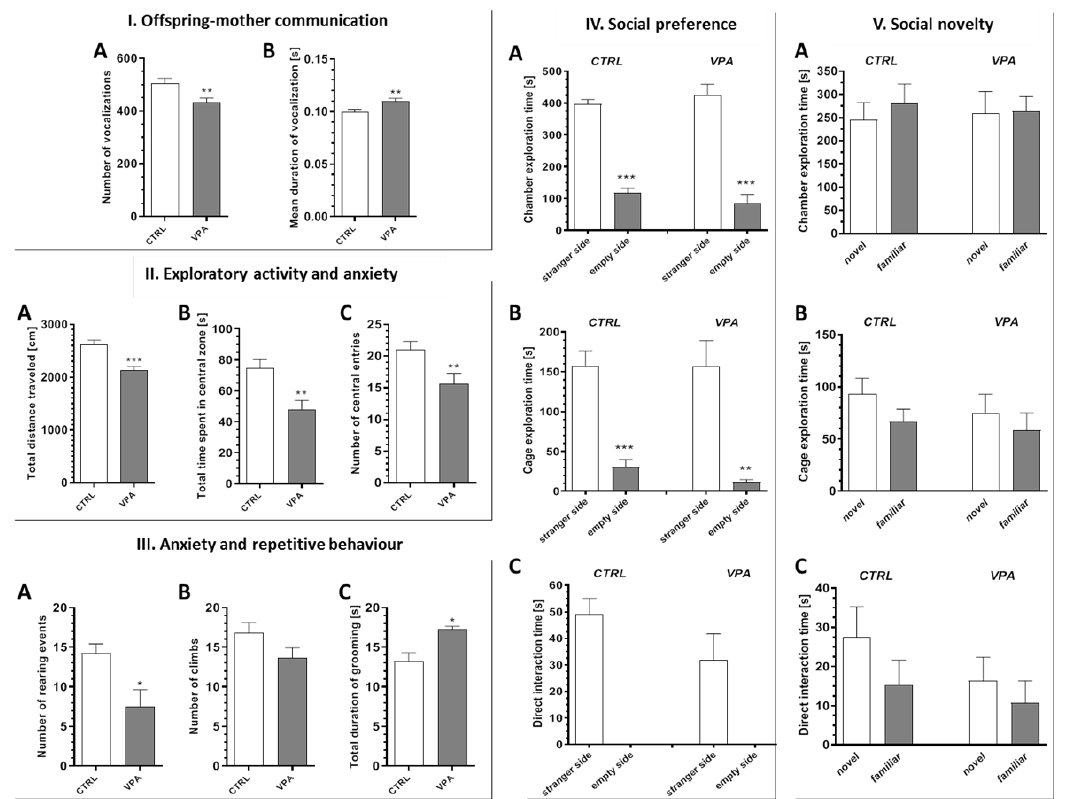
Figure 1. The effect of prenatal exposure to valproic acid (VPA) on offspring behaviour. I . The